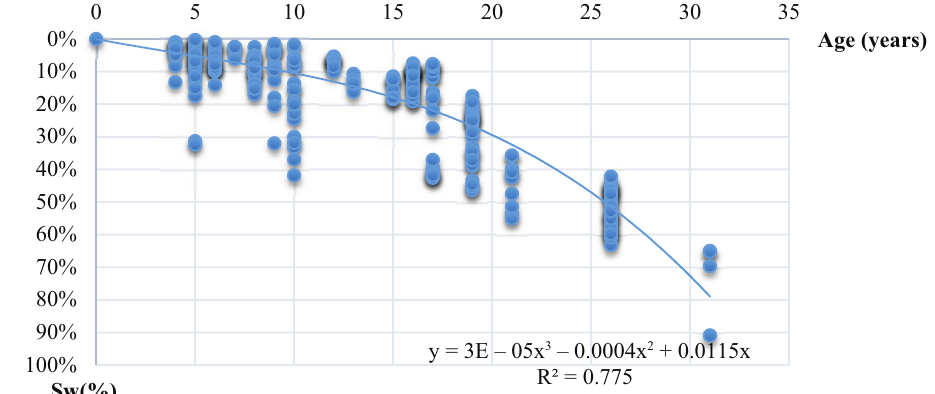
y = 3E – 05x 3 – 0.0004x 2 + 0.0115x R² Figure 2. Degradation curve obtained from the 274 cases inspected in the fieldwork